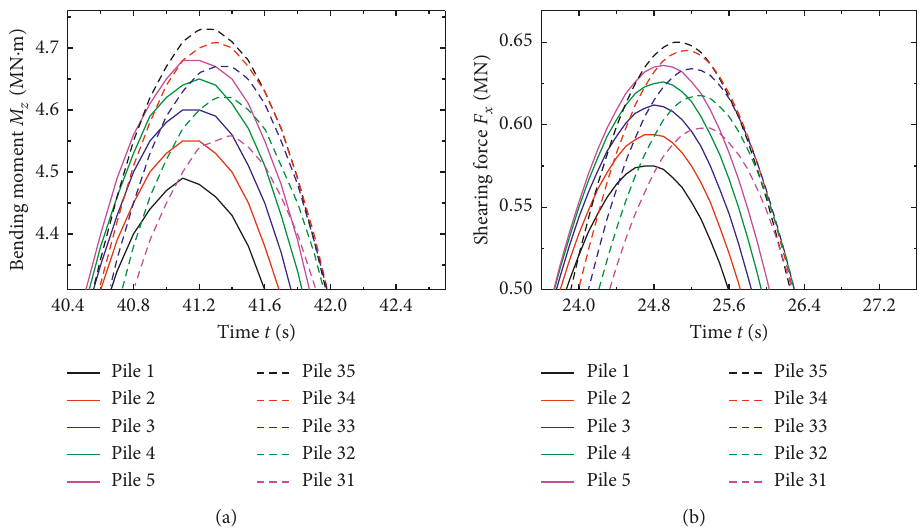
Figure 9: Internal forces of piles. (a) Bending moment. (b) Shearing force.